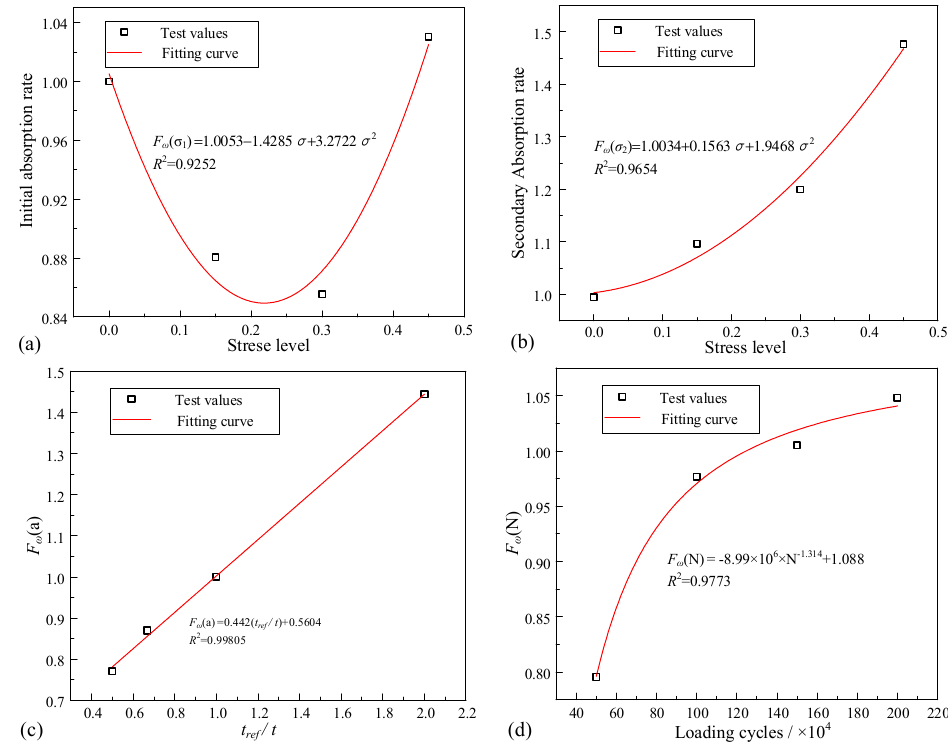
Figure 7. Moisture transport influence factor fitting: ( a ) initial absorption stress level; ( b ) secondary absorption stress level; ( c ) F ω (a) vs. t ref / t ; and ( d ) F ω (N) vs. loading cycles.